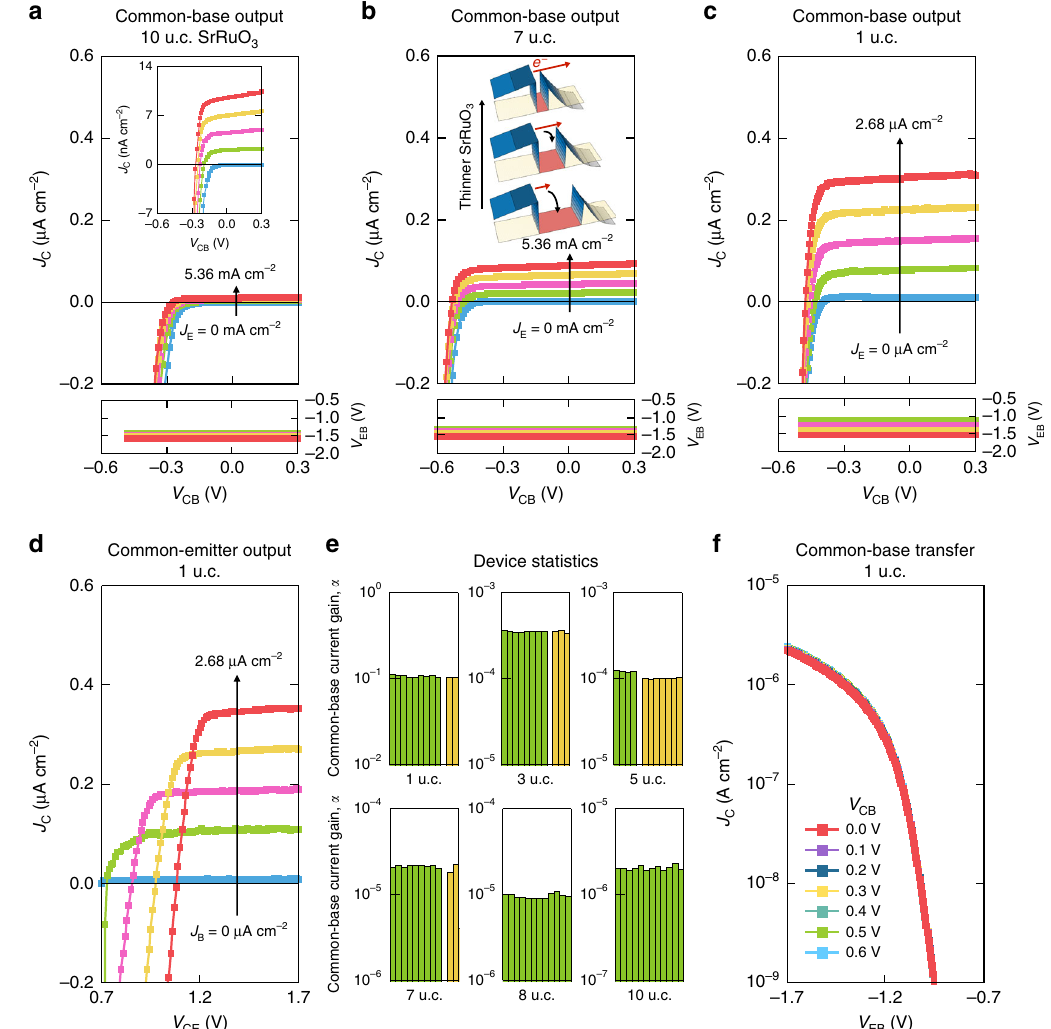
Fig. 3 Room-temperature electrical characterization of variable thickness SrRuO 3 HETs. Common-base output characteristics (top) and voltage feedback (bottom) for SrRuO 3 thicknesses of a 10 u.c. and b 7 u.c., as J E is increased from 0 to 5.36 mA cm − 2 , in 1.34 mA cm − 2 steps; and c 1 u.c., as J E is increased from 0 to 2.68 μ A cm − 2 , in 0.67 μ A cm − 2 steps. The inset to a shows the region where clear transconductance can be seen for 10 u.c. SrRuO 3 thickness. The inset to b shows a schematic illustration of the increase of hot-electron transfer as the base becomes thinner. The constant voltage feedback curves in the common-base output characteristics demonstrate the complete electrostatic screening by the base metal. d Common-emitter output characteristics for 1 u.c. SrRuO 3 thickness, as J B is increased from 0 to 2.68 μ A cm − 2 , in 0.67 μ A cm − 2 steps. e Device statistics on common-base current gain α . For a speci fi ed SrRuO 3 thickness, each bar represents a single device and each color represents a distinct sample from a different fabrication run. f Common- base transfer characteristics for 1 u.c. SrRuO 3 thickness with V CB ranging from 0.0 to 0.6 V, in 0.1 V steps. V EB required for the onset of J C is independent of V CB , indicating pure HET